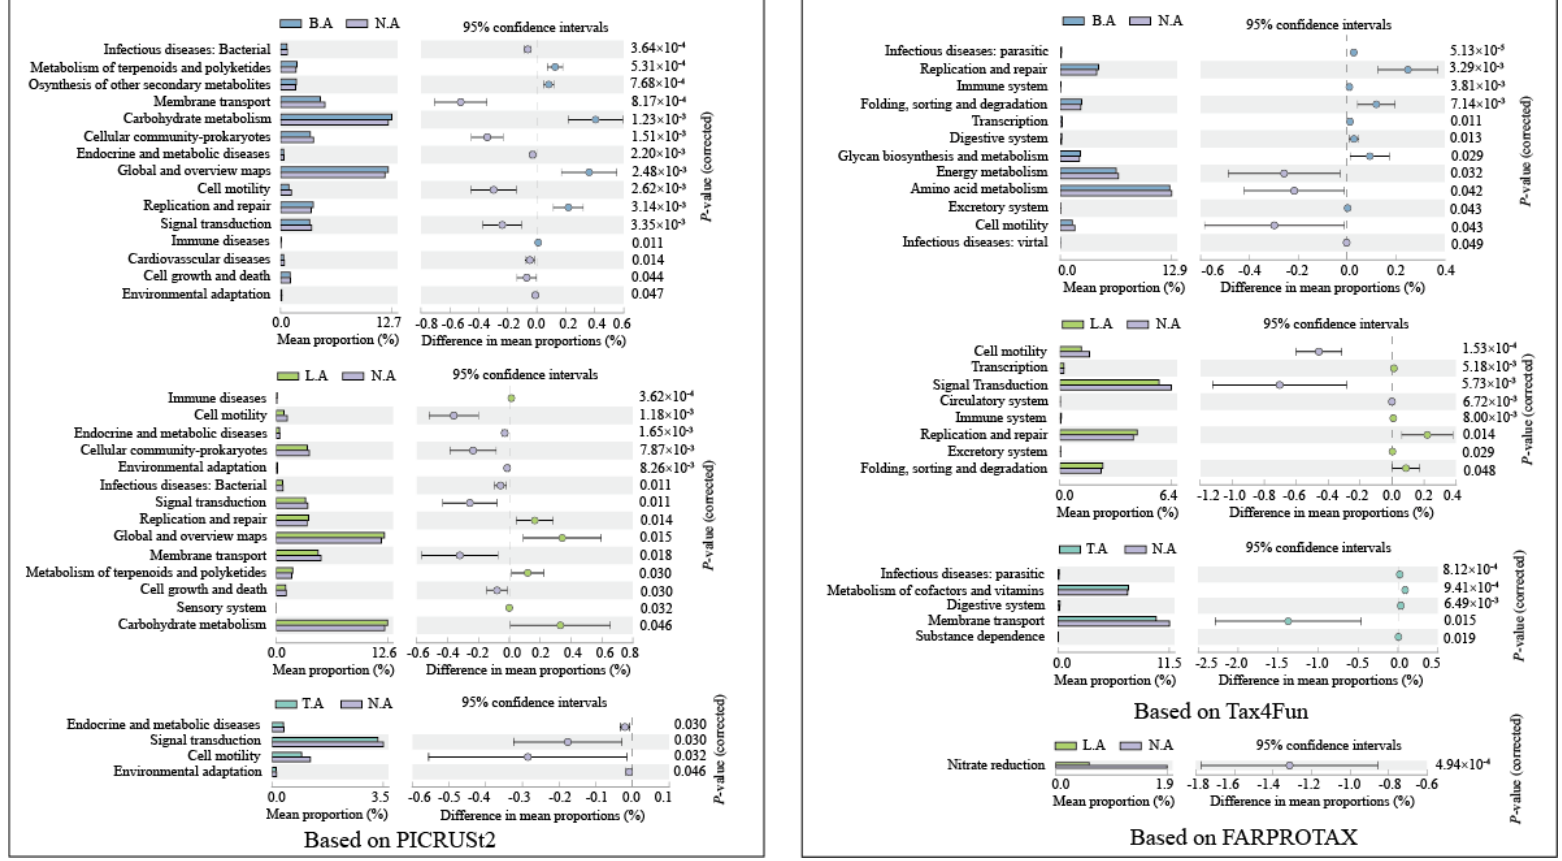
Figure 4. The functional composition of significant changes based on PICRUSt2, Tax4Fun, and FARPROTAX using the response ratio method at a 95% confidence interval (CI).